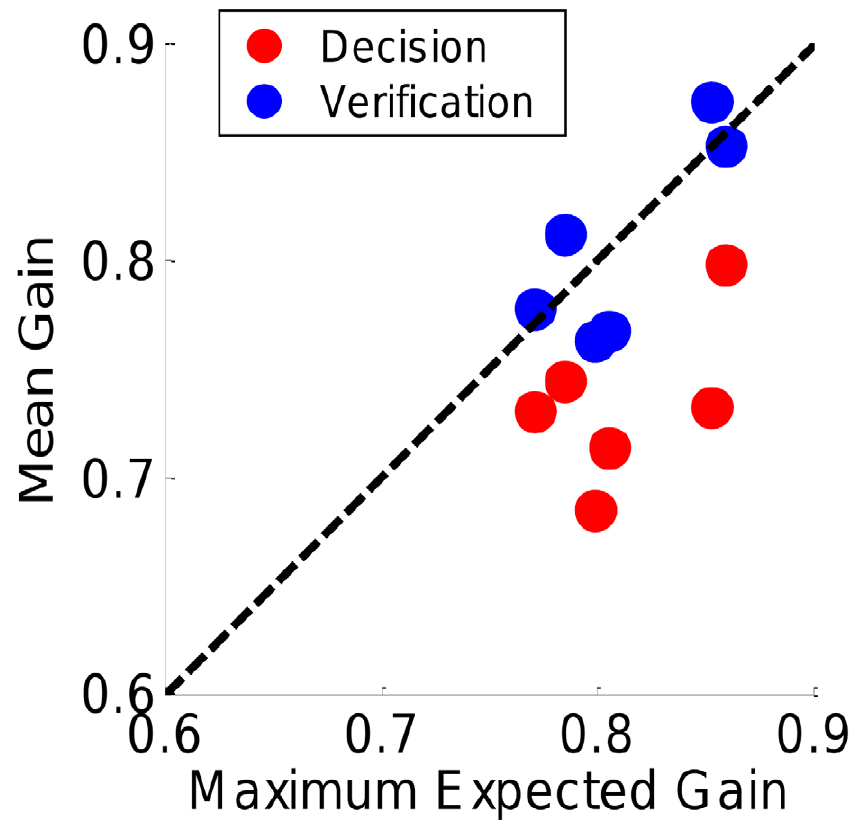
Figure 6. Comparison to Maximum Expected Gain. Each observer’s mean gain in the decision phase (in red) and in the verification phase (in blue) is plotted versus the maximum expected gain possible for that observer. The red points are consistently below the 45 degree line indicating that observers failed to maximize expected gain as predicted by the model in the decision phase. The blue points on the other hand are scattered around the 45 degree line. Observer’s gain approached the maximum possible gain when the observer executes the eye movement strategy that maximizes expected gain as predicted by the model.